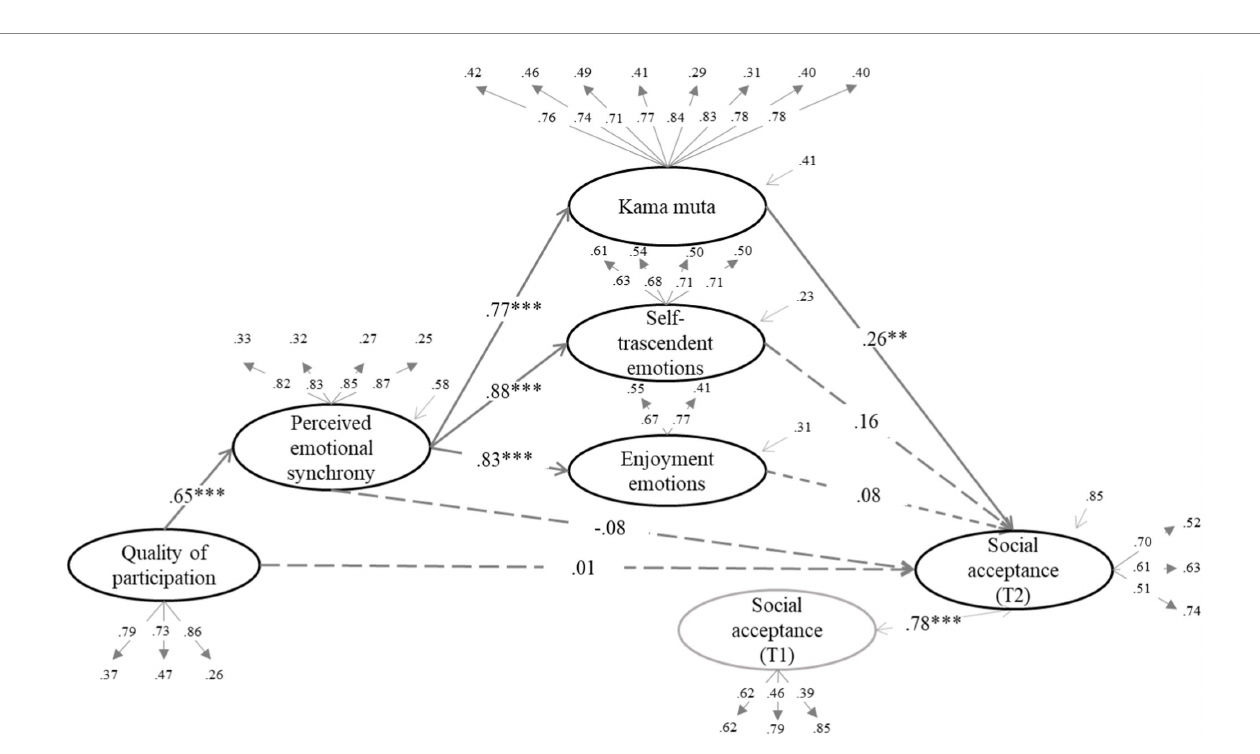
FIGURE 2 Perceived emotional synchrony and emotions as mediators of the effect of quality of participation on social acceptance controlling for pre-participation scores. Model fit: χ 2 = (404, 313) = 904.186, p < 0.001, CFI = 0.900, TLI = 0.888, RMSEA = 0.068, SRMR =